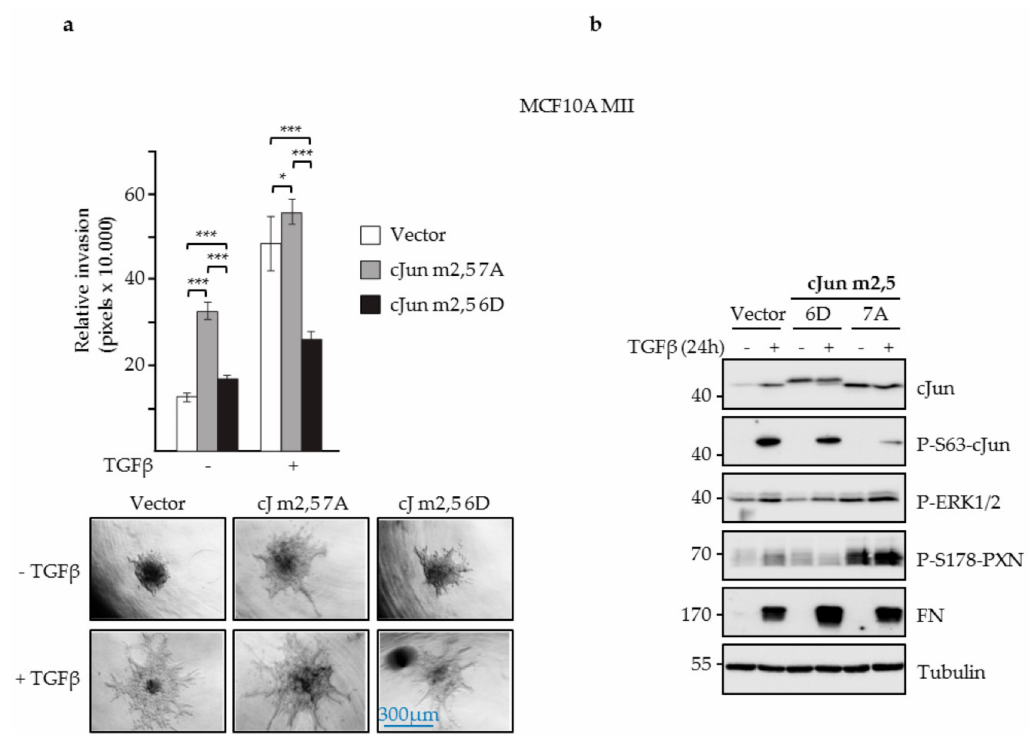
Figure 6. E ff ects of cJun dimerization-specific mutants, and phosphorylation-deficient- and mimicking mutants on collagen invasion. ( a ) Collagen invasion (pixels x 10.000) of MCF10A MII spheroids stably overexpressing cJun-(cJ)-m2,5-6D or cJun-m2,5-7A. Pictures of spheroids were taken 32. h after embedding (bottom) and relative invasion was quantified as the mean area that the spheroids occupied (top); * p < 0.05, *** p < 0.001. ( b ) Immunoblot analysis of the MCF10A MII cells overexpressing cJun-m2,5-6D or